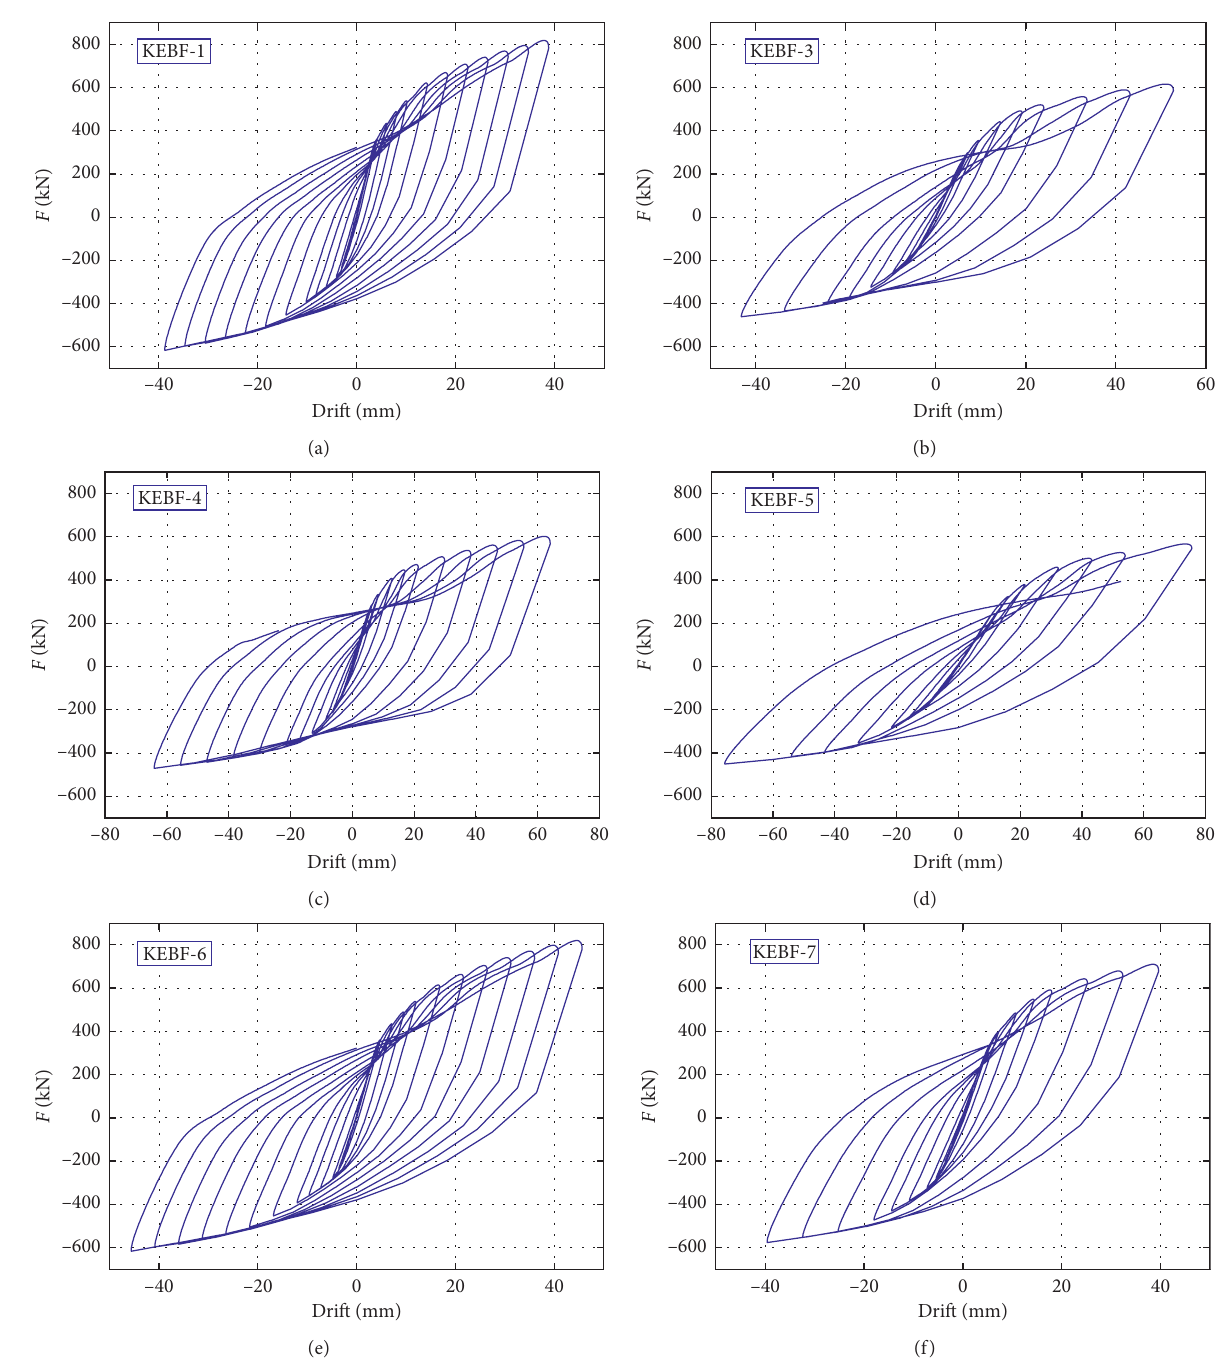
Figure 34: The load-displacement hysteresis curve of each Figure 34 is the load-displacement hysteresis curve of each model. The hysteresis curve of KEBF-1 model is relatively full. The length ratio of link of KEBF-1 model is less than 1.6, which is a shear link. The hysteresis curves of all models (from the KEBF-2 to KEBF-5) show different degrees of pinching. It is mainly because the components are bolted, and there is a slip phenomenon during loading. With the increase of the length of the link, the pinching phenomenon increases.